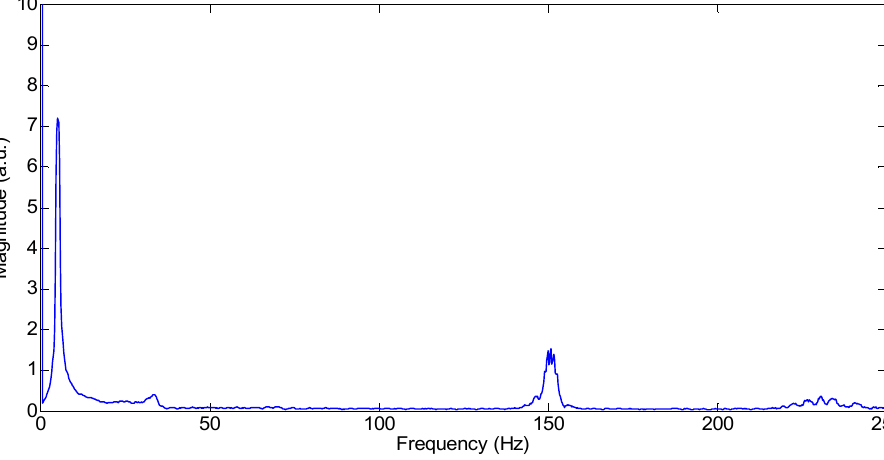
Figure 7. FFT data of cantilever vibration with a smaller peak at 150 Hz due to the phone.